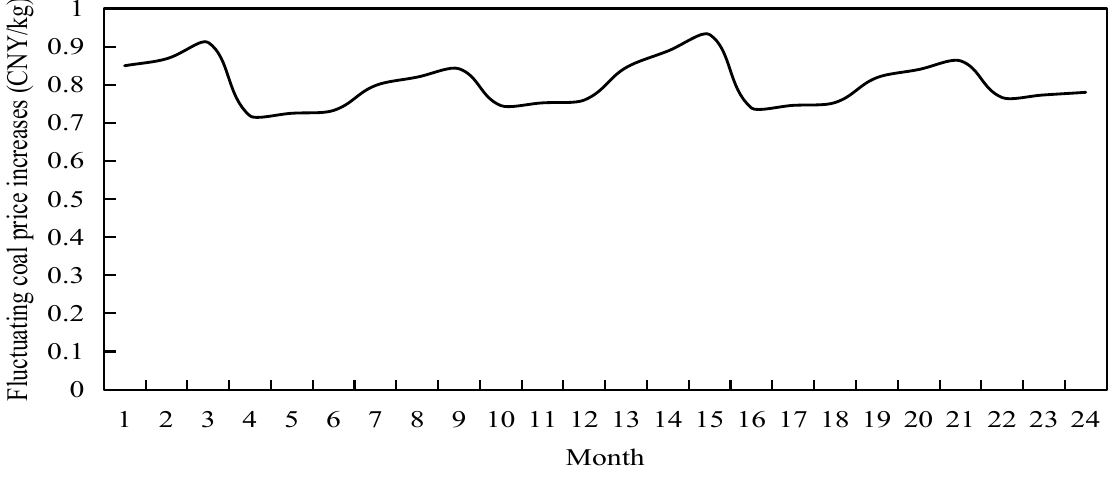
Figure 15. Monthly fluctuations of coal price rise.